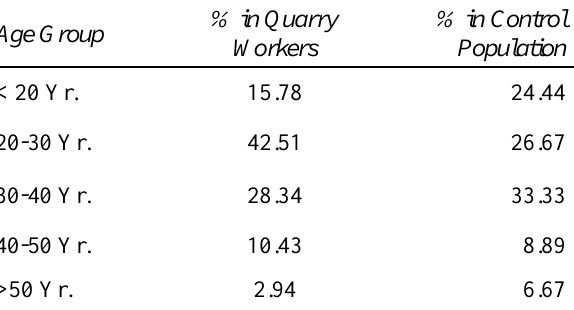
Table 1: Particulate concentration for different activities